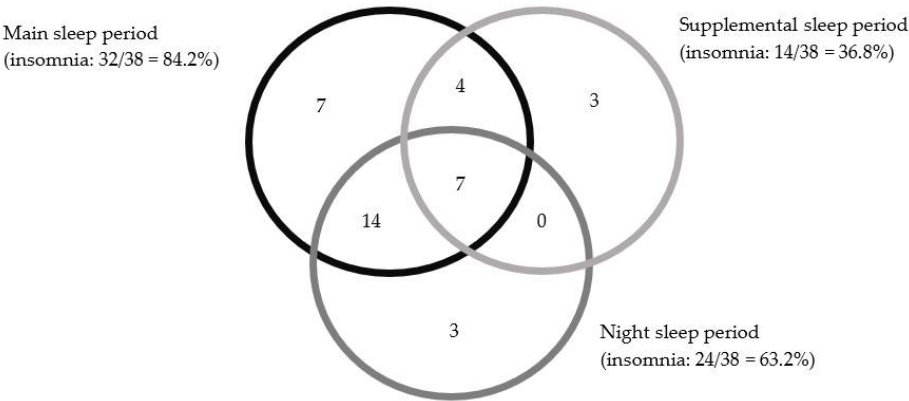
Figure 1. Distribution of night workers with SWD that includes insomnia symptoms ( n = 38) across each of sleep period. Note. The size of circles has no meaning.